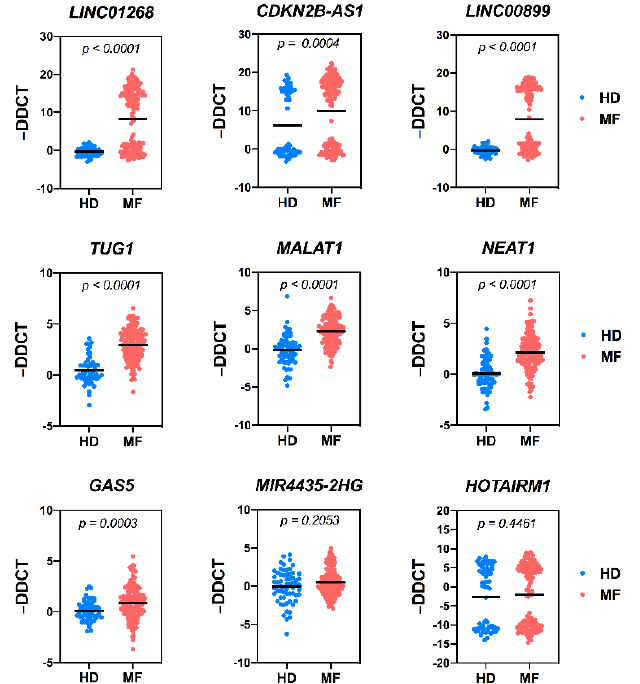
Figure 2. Circulating levels of lncRNAs in HD and MF samples. Scatter dot plots represent the circulating plasma levels of selected lncRNAs in control (HD) and MF samples. Data are expressed as − ∆∆ CT using H19 lncRNA as endogenous control and the median ∆ CT of the group of control samples as calibrator. Control samples are represented by blue dots, whereas MF sample by red dots. The black horizontal line in middle represents the median value. p = p -value computed by non- parametric Mann–Whitney U test. N = 65 for control samples; n = 143 for MF samples. HD = healthy donor, MF = myelofibrosis samples.